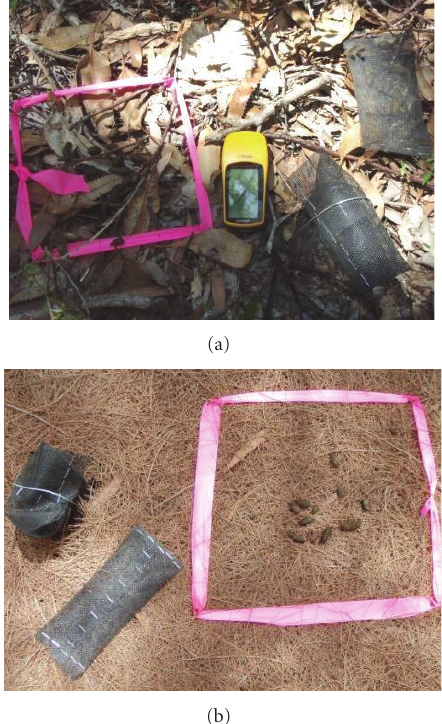
Figure 1: Example of two sites showing plot, cap, and bag, on two di ff erent ground layer types. (a) Complex three-dimensional litter, (b) simple Allocasuarina sp.